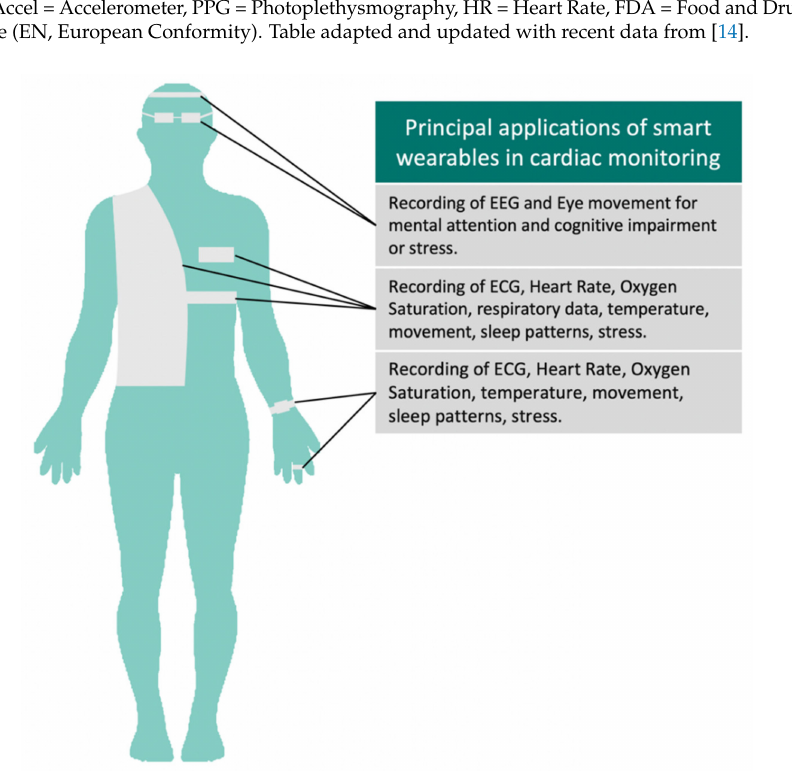
Figure 2. Applications of smart wearables in cardiac monitoring. Different devices can be adapted to textile or everyday items such as watches, glasses, or rings to fit the patient’s style and comfort. These can capture a variety of important physiological and behavioral